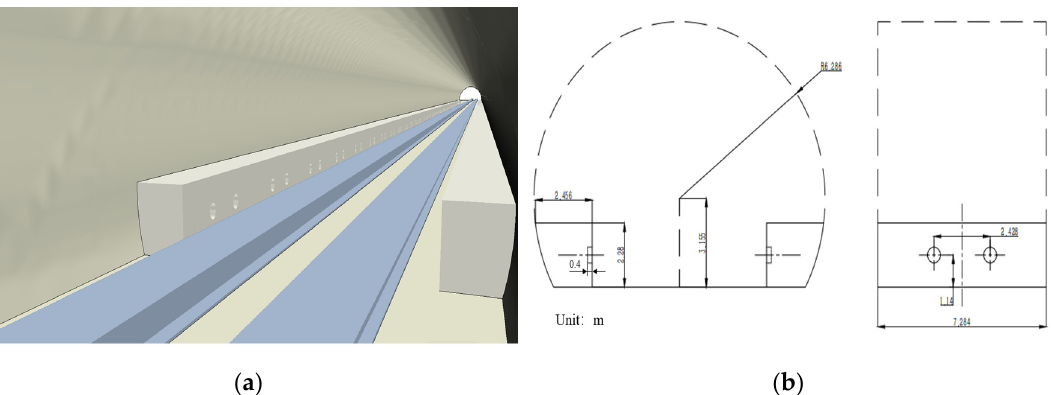
Figure 2. Helmholtz resonator. ( a ) Helmholtz resonators 3D simulation; ( b ) Helmholtz resonator structure.